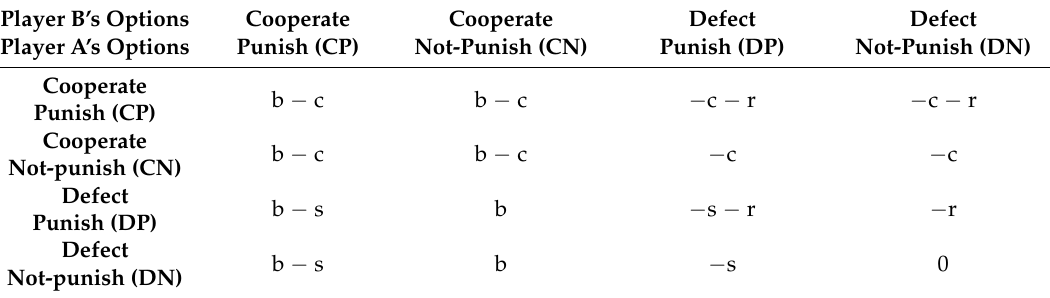
Table 2. Payoffs player A obtains in donation-punishment